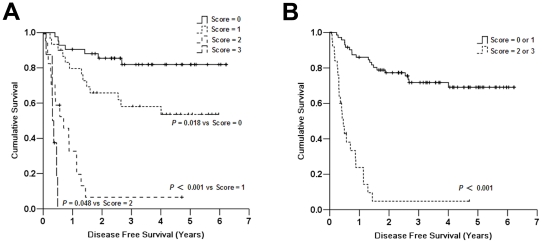
Disease-free survival for patients classified according to the preoperative prognostic score.(A) The Kaplan-Meier curves showed there was a significant difference in DFS among four groups of patients with score 0 to 3. (B) A significant difference in DFS existed when patients were reclassified into two groups (score 0 or 1, and 2 or 3).